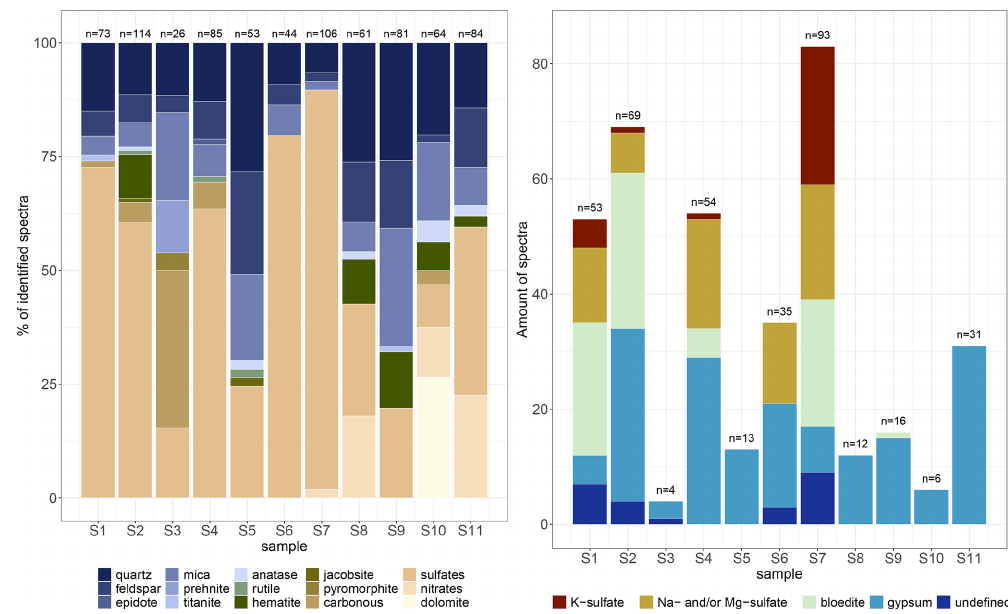
Figure 5. Identified Raman spectra of micro-inclusions in EGRIP Holocene ice; n is the total amount of identified spectra per sample. The two deepest samples are from the Younger Dryas and Bølling Allerød and have by far the highest water-insoluble particle concentrations. (a) All identified Raman spectra per sample. For better visibility some Raman spectra are condensed in groups (e.g. sulfates and mica). (b) Identified sulfates in detail. Sulfate diversity decreases below 900m. Table 2. Most abundant Raman spectra in EGRIP Holocene ice and localisation data. Mg and K sulfate minerals could not be identified clearly. Sulfates, except gypsum, at grain boundaries were not distinguished and are indicated with hyphens. Details on grain boundary statistics are shown in Table 1 in Stoll et al.